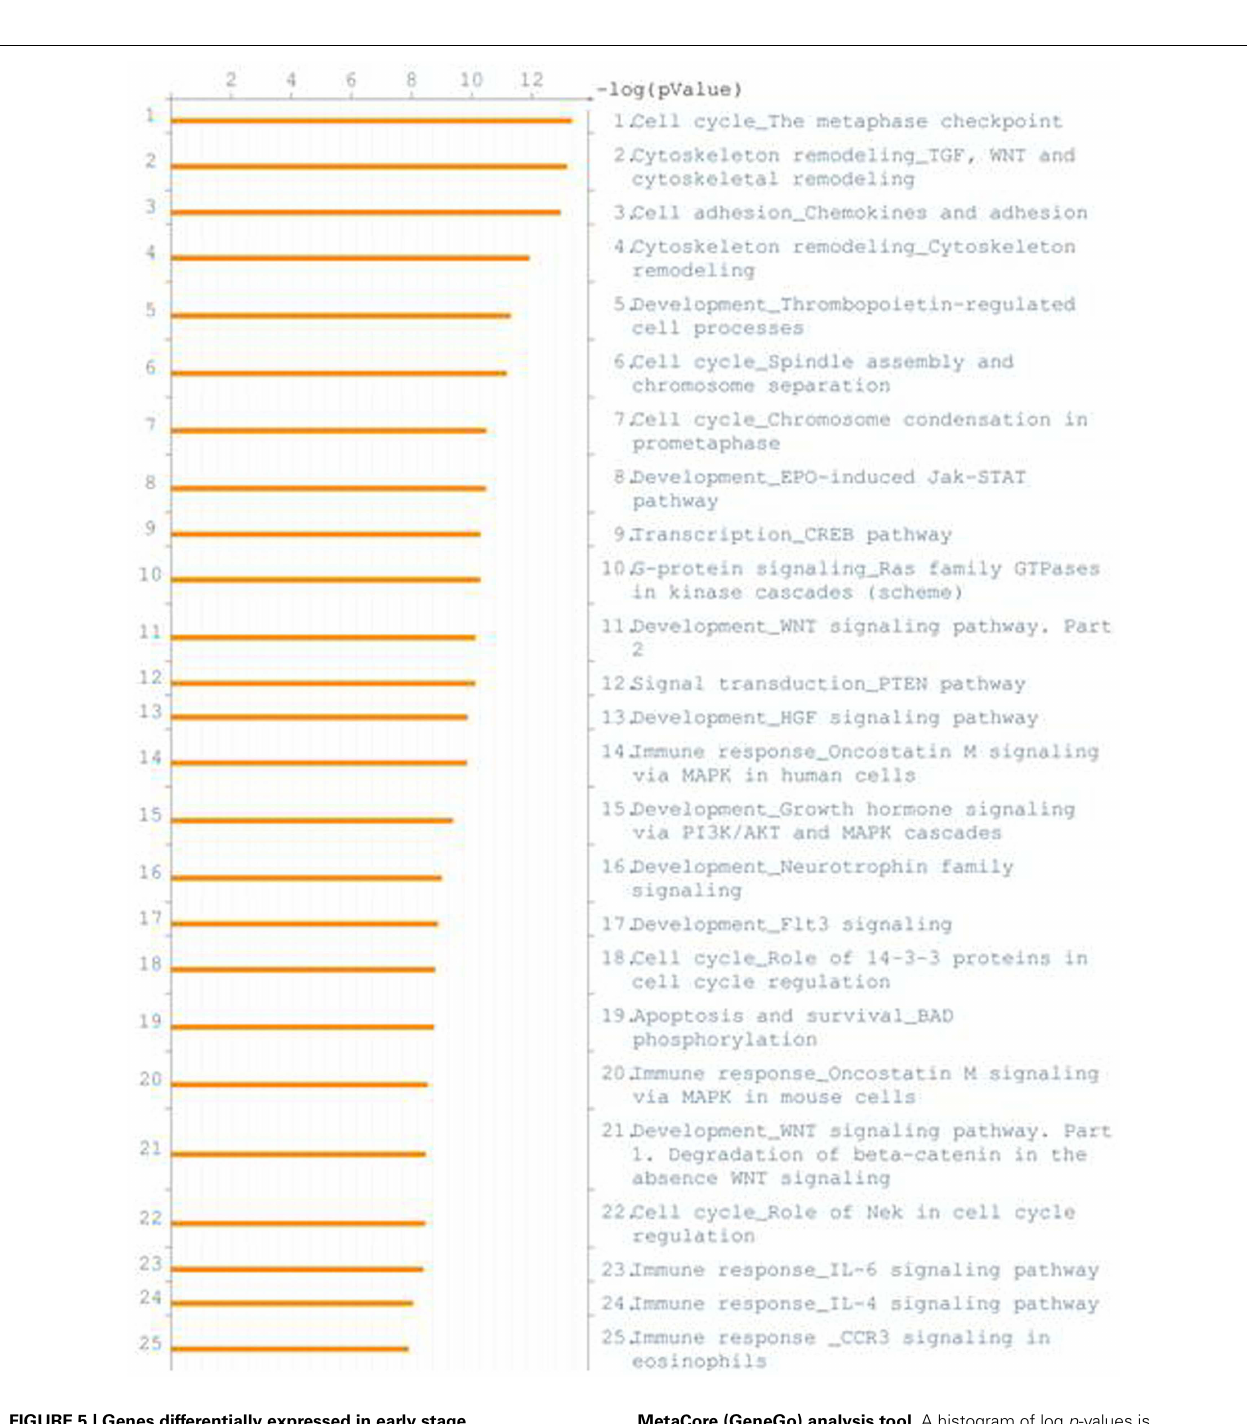
FIGURE 5 | Genes differentially expressed in early stage endometrial samples compared to normal epithelia were evaluated for enrichment of biologic pathways using the